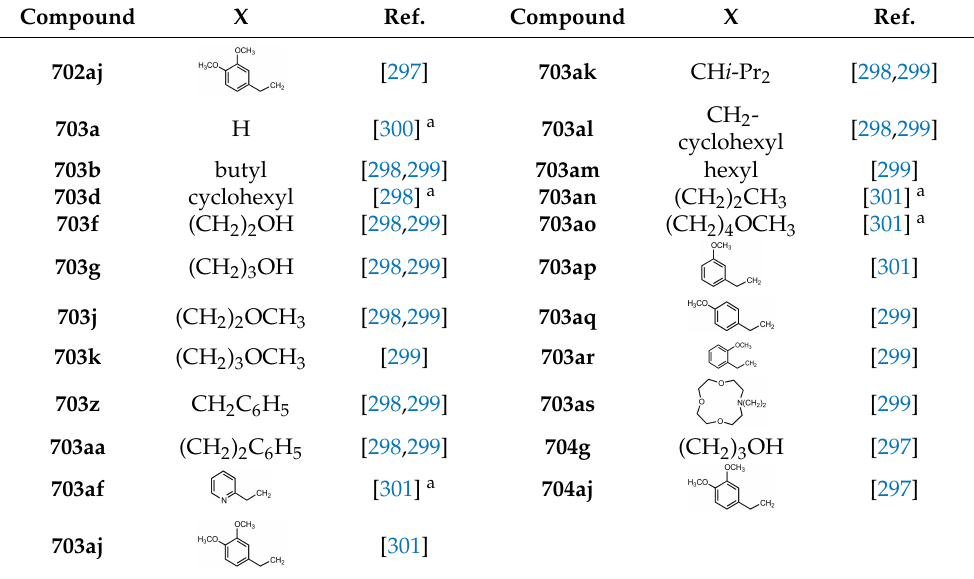
Table 3. A series of β - D -glucoside-based aza-crown ethers synthesised by Bak ó and co-workers. Compound X